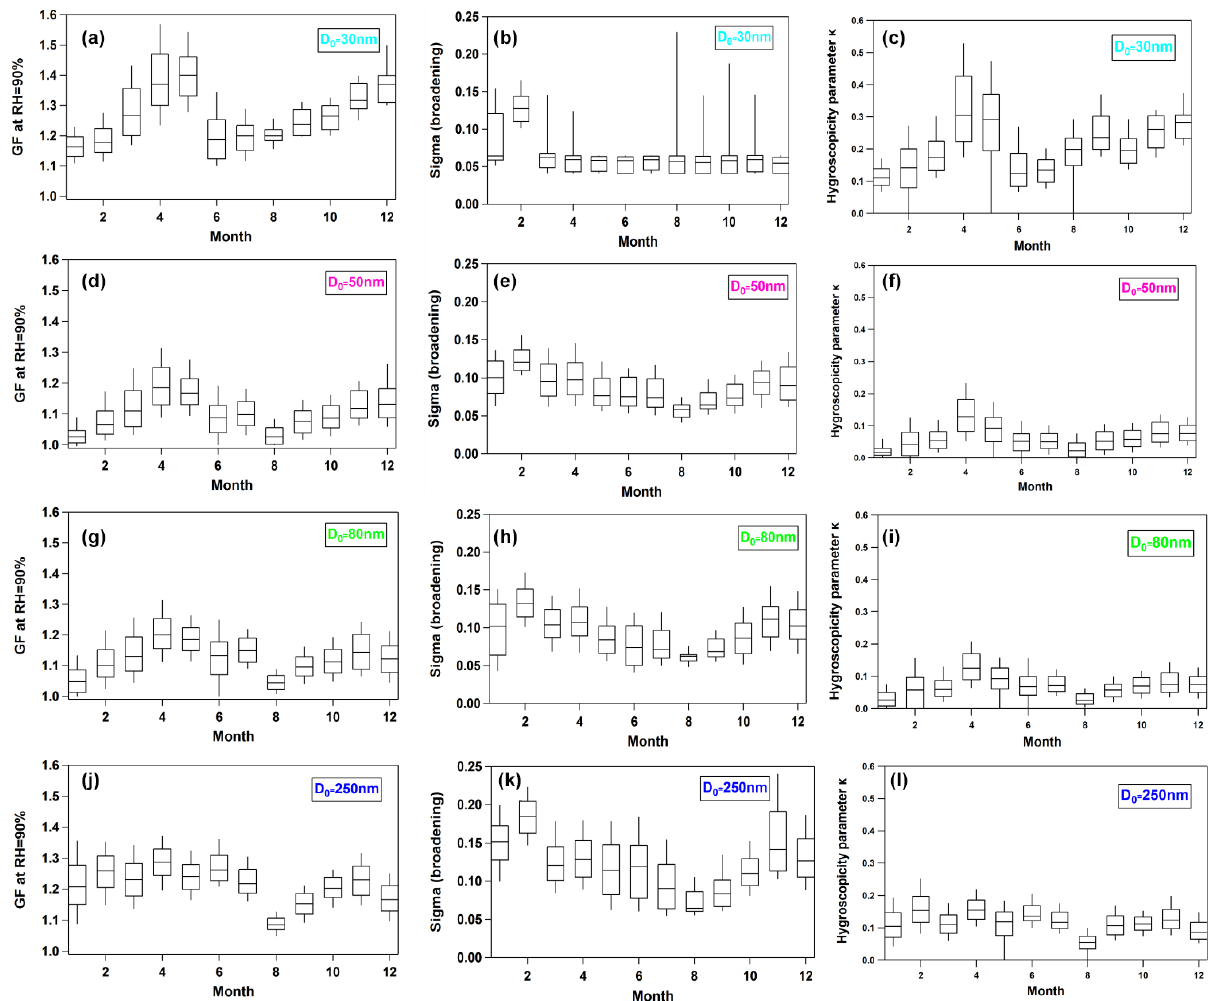
Figure 5. Percentiles of the GF-PDF, standard deviation σ and hygroscopicity parameter κ for each dry size and for each month. Box plots with whiskers show 10th, 25th, 50th, 75th and 90th